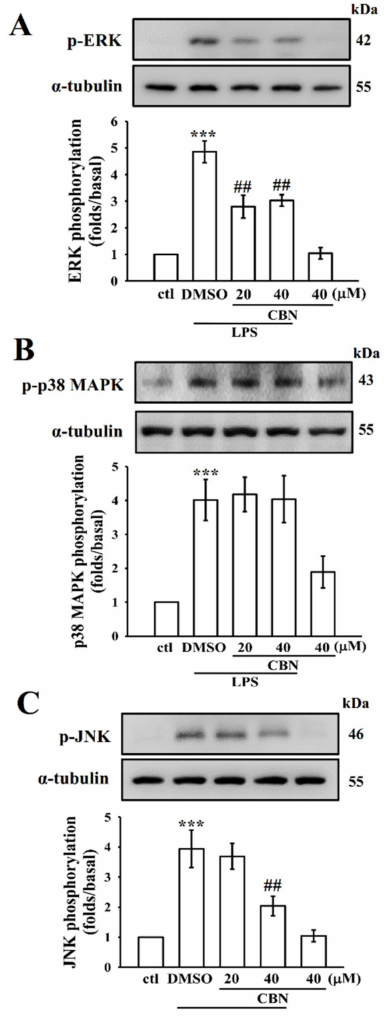
Figure 2. Effects of CBN on ERK1/2, p38MAPK, and JNK1/2 phosphorylation in LPS-induced RAW cells. Cells were treated with 0.1% DMSO or CBN (20–40 µ M) for 20 min, and then induced by LPS (1 µ g/mL) for 30 min. The ( A ) ERK, ( B ) p38MAPK, and ( C ) JNK phosphorylation was detected by immunoblotting. Data are expressed as the means ± S.E.M. ( n = 4). *** p < 0.001, LPS vs. control cells; ## p < 0.01, LPS vs. treatment